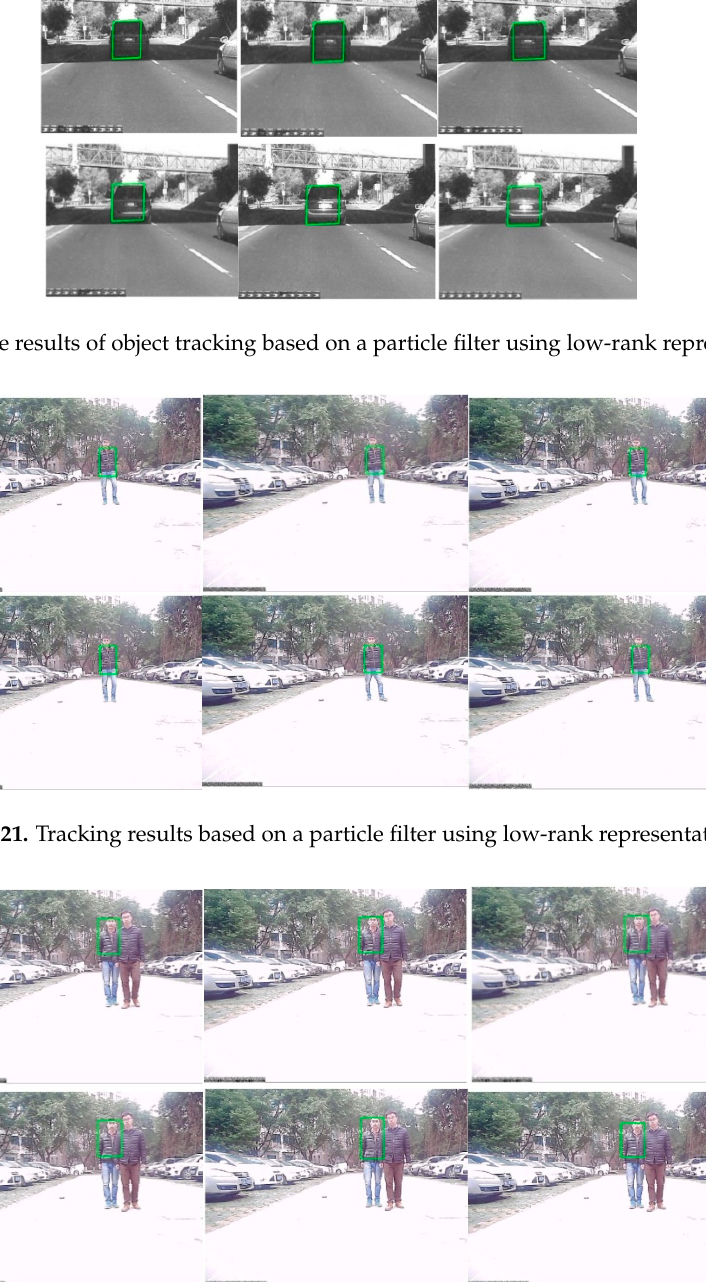
Figure 22. Tracking results based on a particle filter using low-rank representation under a sheltered object.